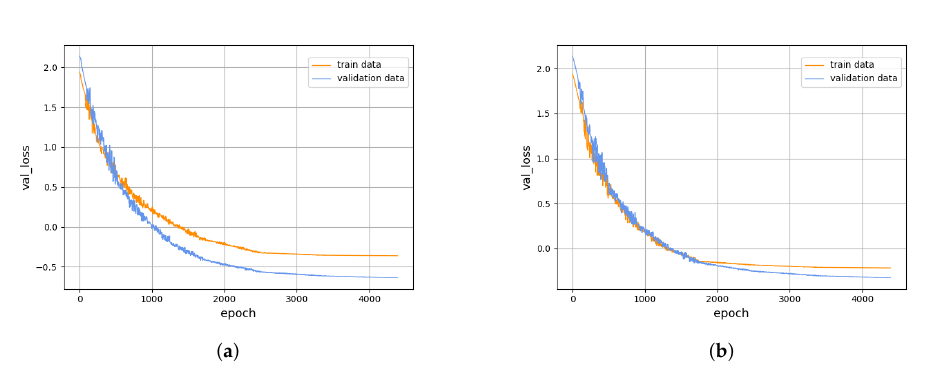
Figure 8. Training results of the CVAEWD and HMM classifier. ( a ) Loss curve after adding the regularization penalty term. ( b ) Loss curve after adding the dropout layer.